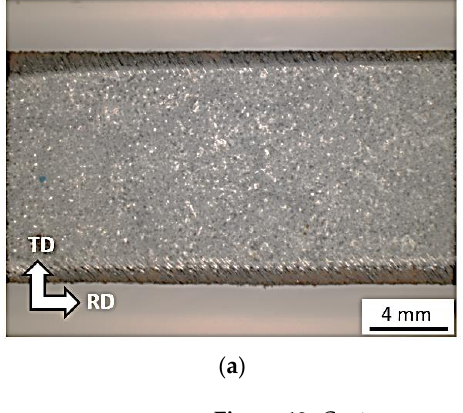
Figure 11. Metallographic images of the matrix and delamination of the Zn layer during tensile test as a function of plastic strain for strain rate 32.0 × 10 −3 s −1 . ( a ) ε = 5.0%, ( b ) ε = 11.8%, ( c ) ε = 18.7%, ( d ) ε = 32.5% .